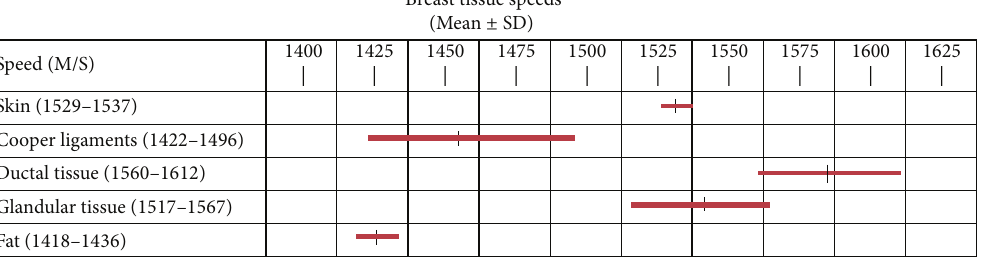
Figure 9: Summary analysis of 250 tissue measurements of speed of sound taken from 3 cadavers and four normal volunteers. Bars represent mean and 1 SD.